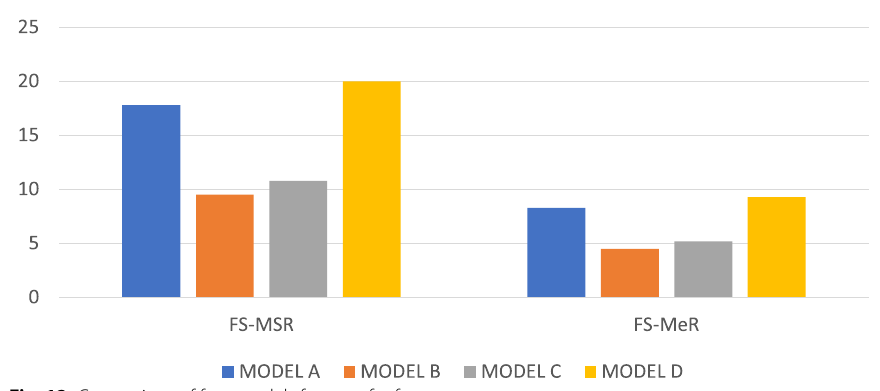
Fig. 12 Comparison of four models factors of safety